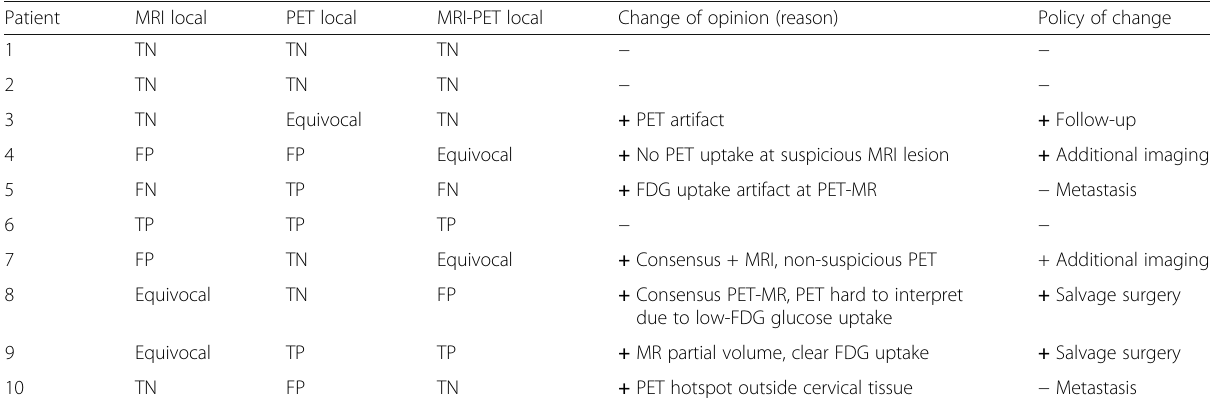
Table 3 Local residual tumor based on MRI (radiologist), PET (nuclear physician), and PET-MRI (consensus radiologist and nuclear physician) scores and change of opinion and policy Patient MRI